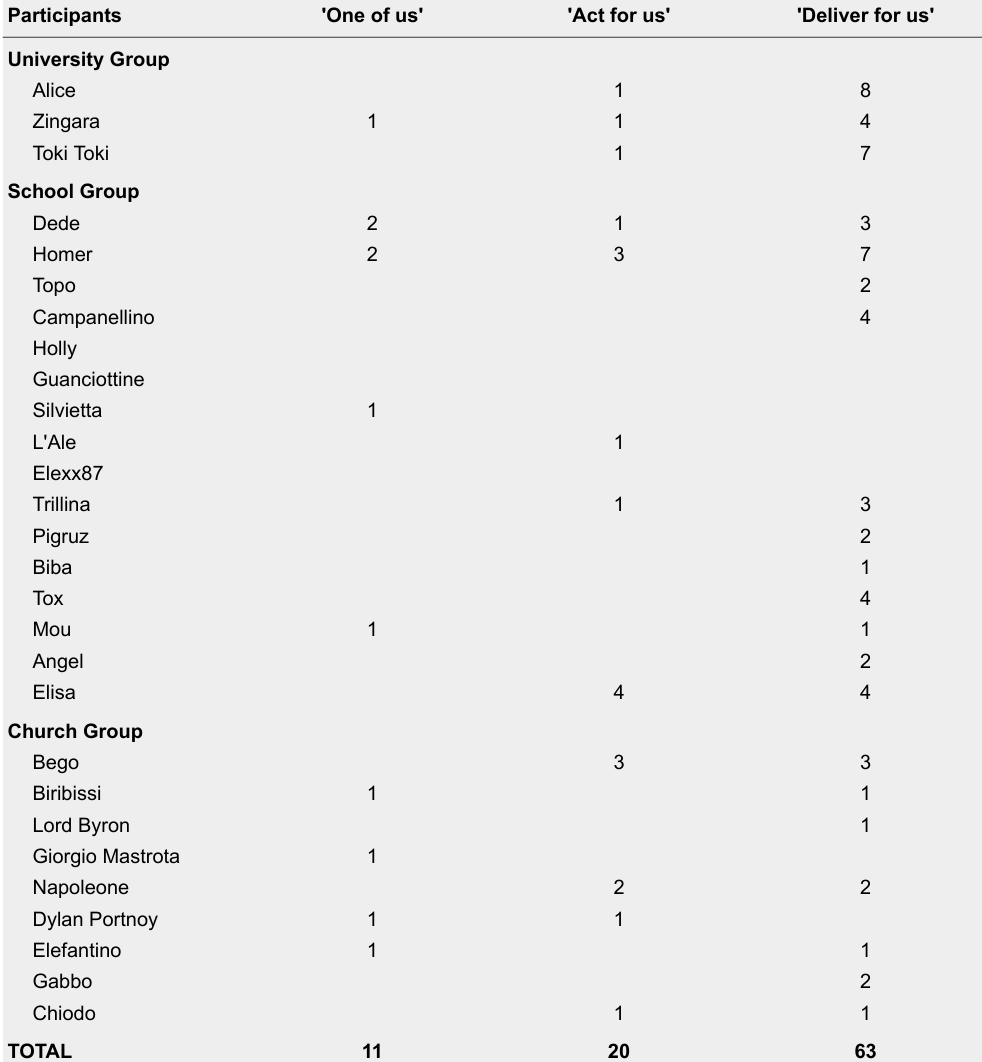
Number of Forms on Which Each Participant Mentions the Three Aspects of the Relationship Between Party/Leader and Participant Group ('One of us', ''Act for us', 'Deliver for us')